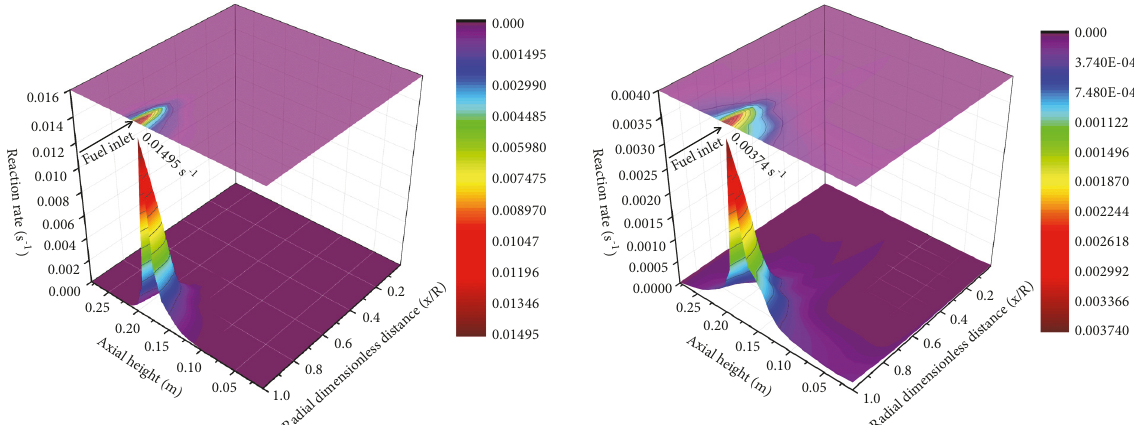
Figure 9: Coal (right) and biomass (left) devolatilization rates at fuel inlet region (s −1 ).